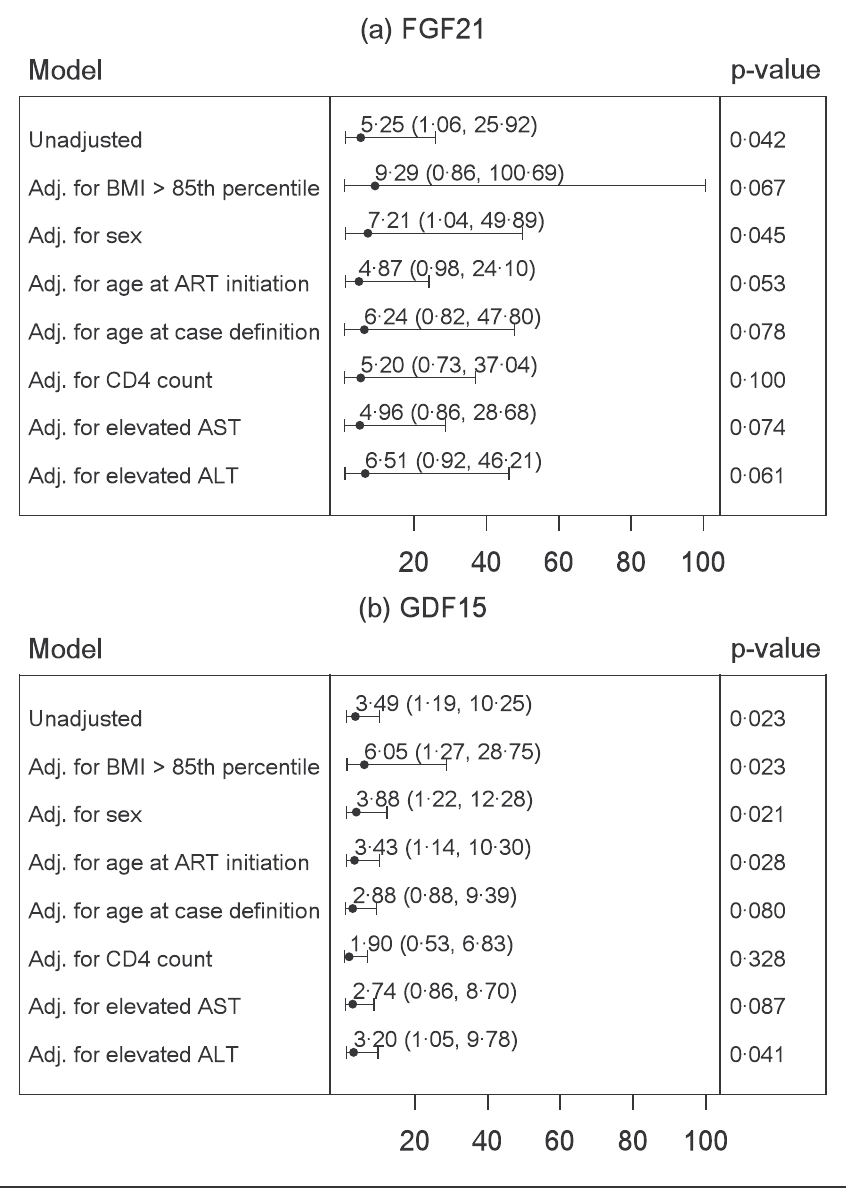
Fig 4. Bivariate conditional logistic regression model results. (a) Models were created comparing natural log- transformed values of FGF21 for MDC4 cases versus MDC0 controls, with individual adjustments for covariates shown. (b) Similar models were created for GDF15 values. Estimates for the odds of MDC4 status vs. MDC0 status obtained from the indicated model (left panels) are represented as points, with bars indicating 95% CI. Statistical p- values for the odds ratio are shown in right panels. Adj. = adjusted; ALT = alanine aminotransferase; ART = antiretroviral therapy; AST = aspartate aminotransferase; BMI = body mass index; CI = confidence interval; FGF21 = fibroblast growth factor 21; GDF15 = growth differentiation factor 15; MDC = mitochondrial disease criteria.